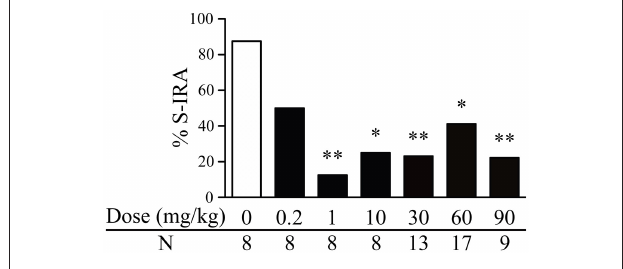
FIGURE 1 | Genistein reduces the incidence of S-IRA in DBA/1 mice. Compared with vehicle control (dose zero), systemic administration of genistein at 1–90 mg/kg significantly decreased the incidence of S-IRA in DBA/1 mice. S-IRA incidence was not significantly altered by genistein at 0.2 mg/kg compared with vehicle control. * p < 0.05; ** p < 0.01: Significantly different from the vehicle control (dose zero).